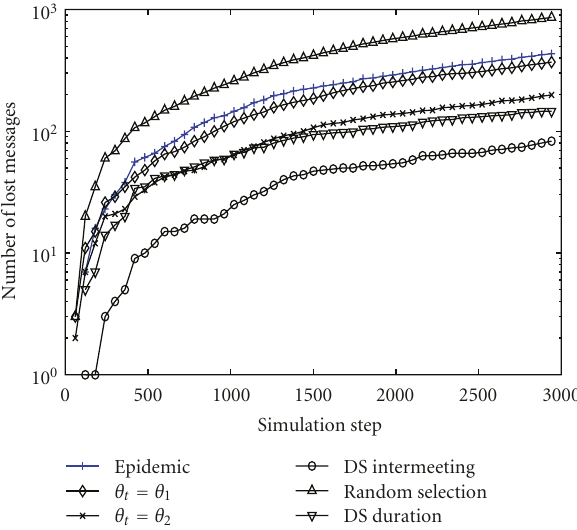
Figure 10: The random selection technique performance compared to the other techniques in terms of the number of lost